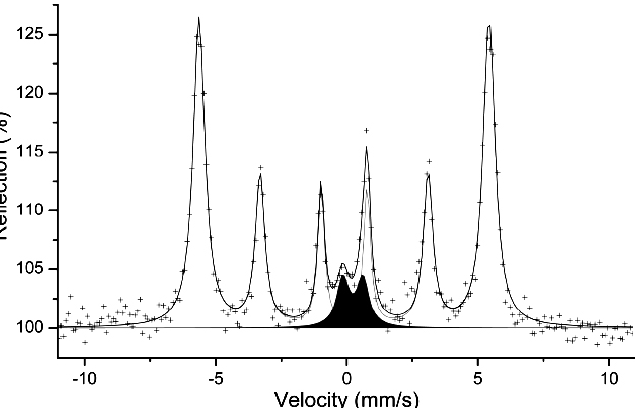
Figure 52. Mössbauer spectrum of the Meridiani Planum iron meteorite observed at the Meridiani Planum, Mars and measured using Opportunity rover in the temperature range 220–230 K. Indicated spectral components are the result of the fit. Adapted from [151].